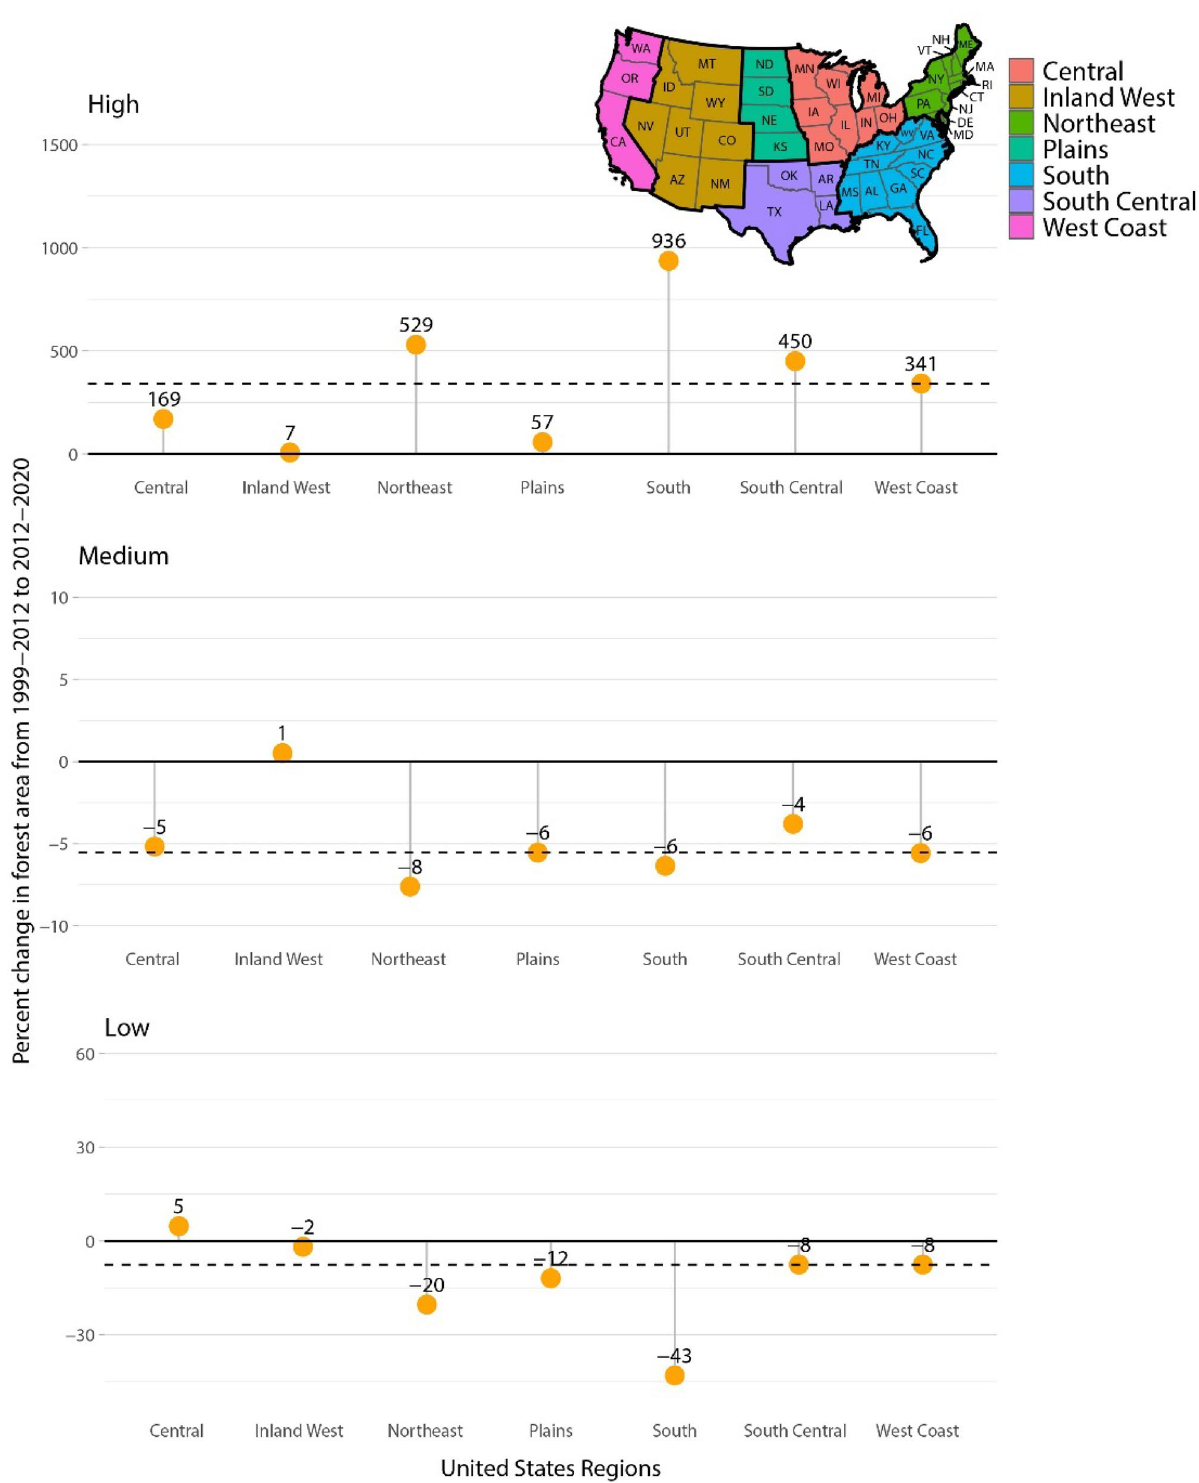
Figure 4. Percentage change in forest land area in low (0.00–0.30), medium (0.31–0.60), and high (0.61 +) relative density conditions by US region from Time 1 (1999–2012) to Time 2 (2013–2020). Dotted line denotes the median percentage change across all regions. Locator map produced in R v3.6.3 52